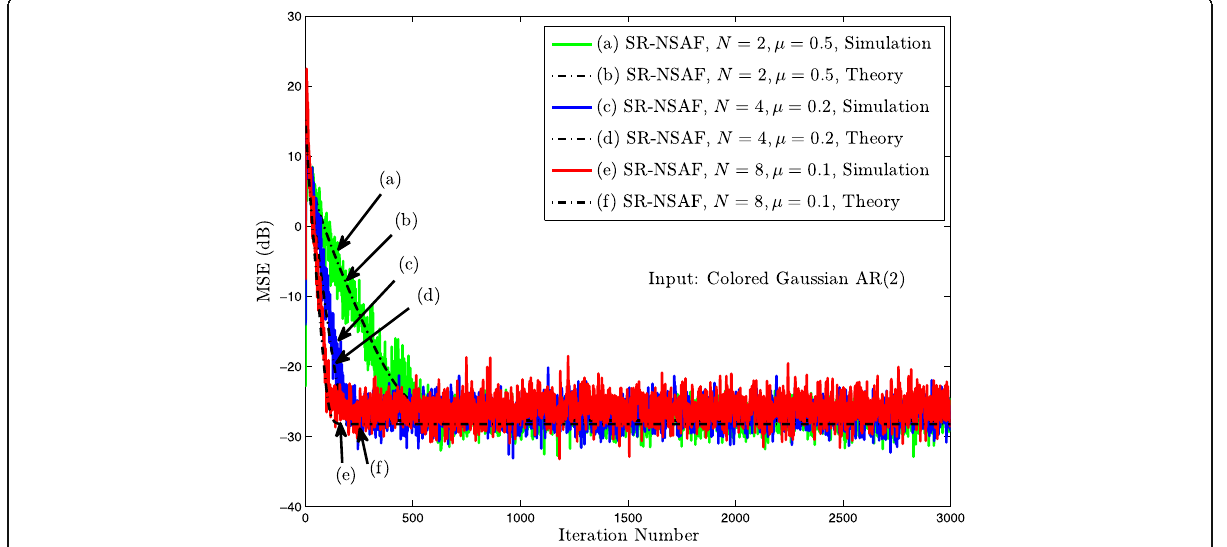
Fig. 19 Simulated and theoretical MSE learning curves of SR-NSAF for different values of N